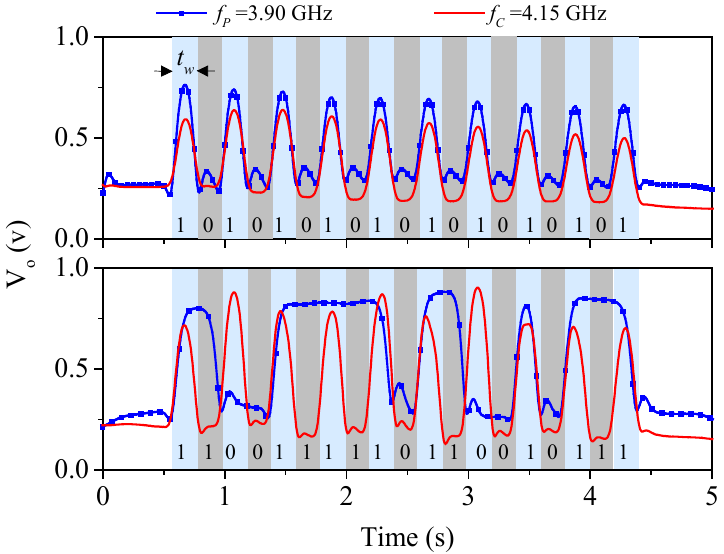
Figure 6. Measured envelope signals (ID code and clock) of the 19-bit tags of Figure 5 with the indicated codes. Reprinted with permission from [64].